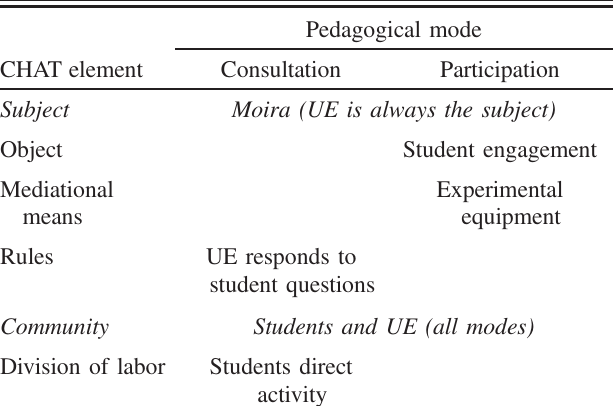
TABLE IV. A tabular depiction of Moira ’ s enacted mixed consultation-participation pedagogical mode, as described above. Each CHAT element (with the exception of the subject, which is Moira, and the community, which is the same in all modes) is characteristic of either the consultation mode or the participation mode as articulated in Ref. [12].